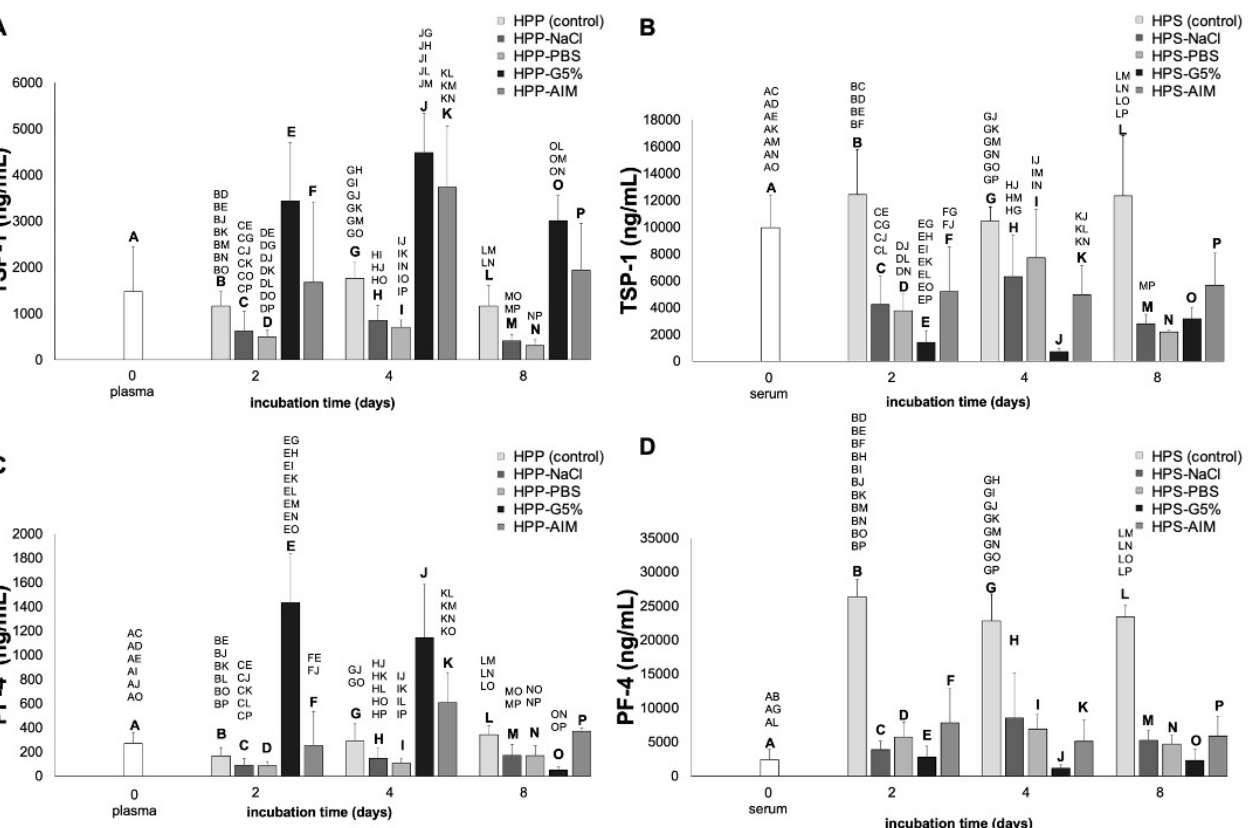
Figure 3. Quantitative analysis of anti-angiogenic growth factor (TSP-1, PF-4) concentration in various hypoxia preconditioned media. Plots showing the concentration of TSP-1 (ng/mL) ( A , B ) and PF-4 (ng/ml) ( C , D ) in fresh plasma and serum, as well as in hypoxia preconditioned plasma (HPP) and serum (HPS) and four different hypoxia preconditioned media substitutes: hypoxia preconditioned normal saline (HPP/HPS-NaCl), hypoxia preconditioned phosphate buffered saline (HPP/HPS-PBS), hypoxia preconditioned Glucose 5% (HPP/HPS-G5%), and hypoxia preconditioned AIM V medium (HPP/HPS-AIM), incubated for 2, 4, and 8 days. Blood donors: n = 4. Two-way repeated measures ANOVA with Tukey’s multiple comparison test. Data points are means ± SD. Capital letter pairs over plots indicate statistical comparison of corresponding data points. For all pair comparisons, p < 0.05.